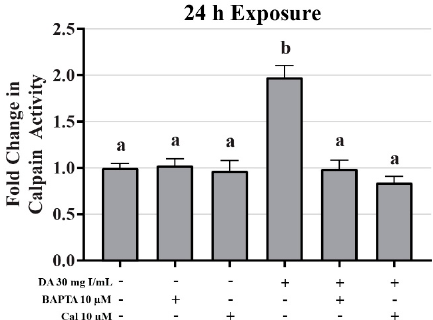
Figure 19. Diatrizoic acid effects on calpain activity in HK-2 cells. DA induced activation of calpain. HK-2 cells exposed to 30 mg I/mL DA for 24 h demonstrated a two-fold increase in calpain activity. Pretreatment with either 10 µM BAPTA-AM (calcium chelator) or 10 µM calpeptin (Cal; calpain pathway inhibitor) completely abrogated DA-induced calpain activity. Different superscripts (a,b) indicate a statistical di ff erence between groups. Values represent mean ± SEM for three independent experiments